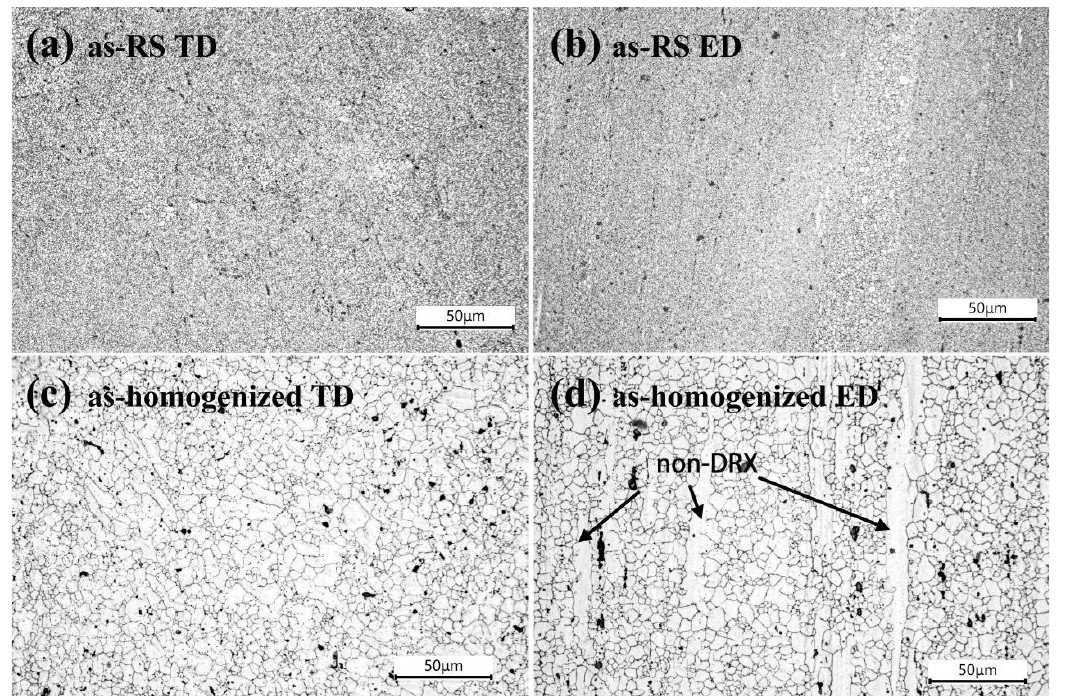
Figure 4. Optical microstructure of the extruded rods of ( a , b ) as-RS AZ31 and ( c , d ) as-homogenized AZ31.